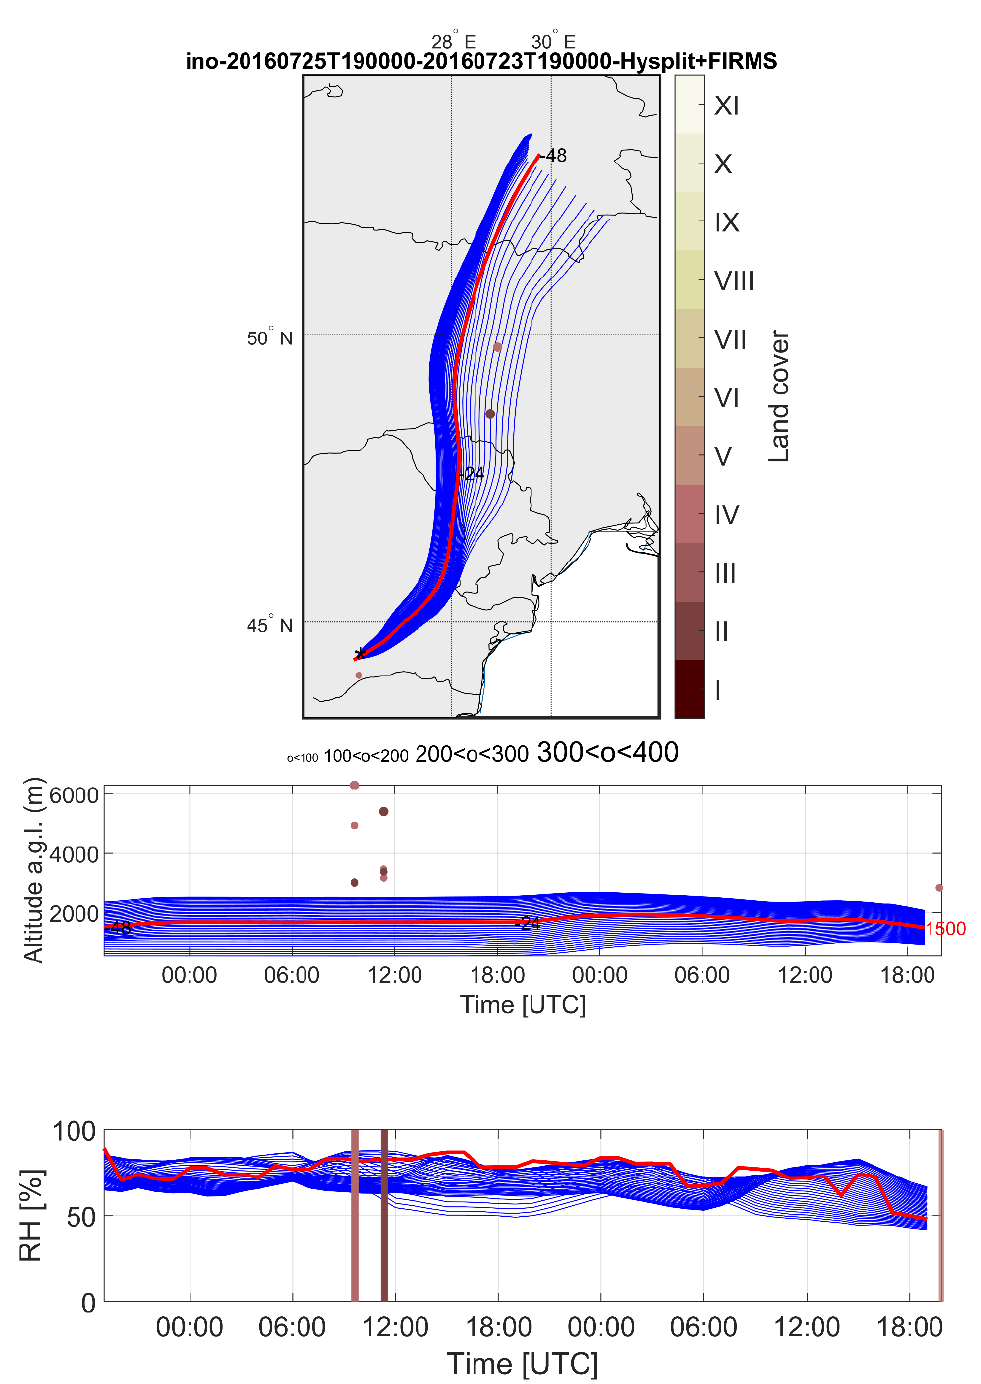
Figure 3. Ensemble back-trajectories (blue lines) and the mean trajectory (red) for 25 July 2016 19:00 UTC. The middle plot shows the trajectory altitudes versus time. The brown dots represent the fires’ locations ( upper plot ) and their injection height ( middle plot ). The smoke middle layer is at 1500 m a.g.l. The lower plot shows RH for both ensemble and mean trajectories. The location of the fires is shown by bars. Note that the fires’ colors represent the land cover type (legend upper plot ), while their dimensions are set up according to their FRP size in MW (upper plot, x − label).